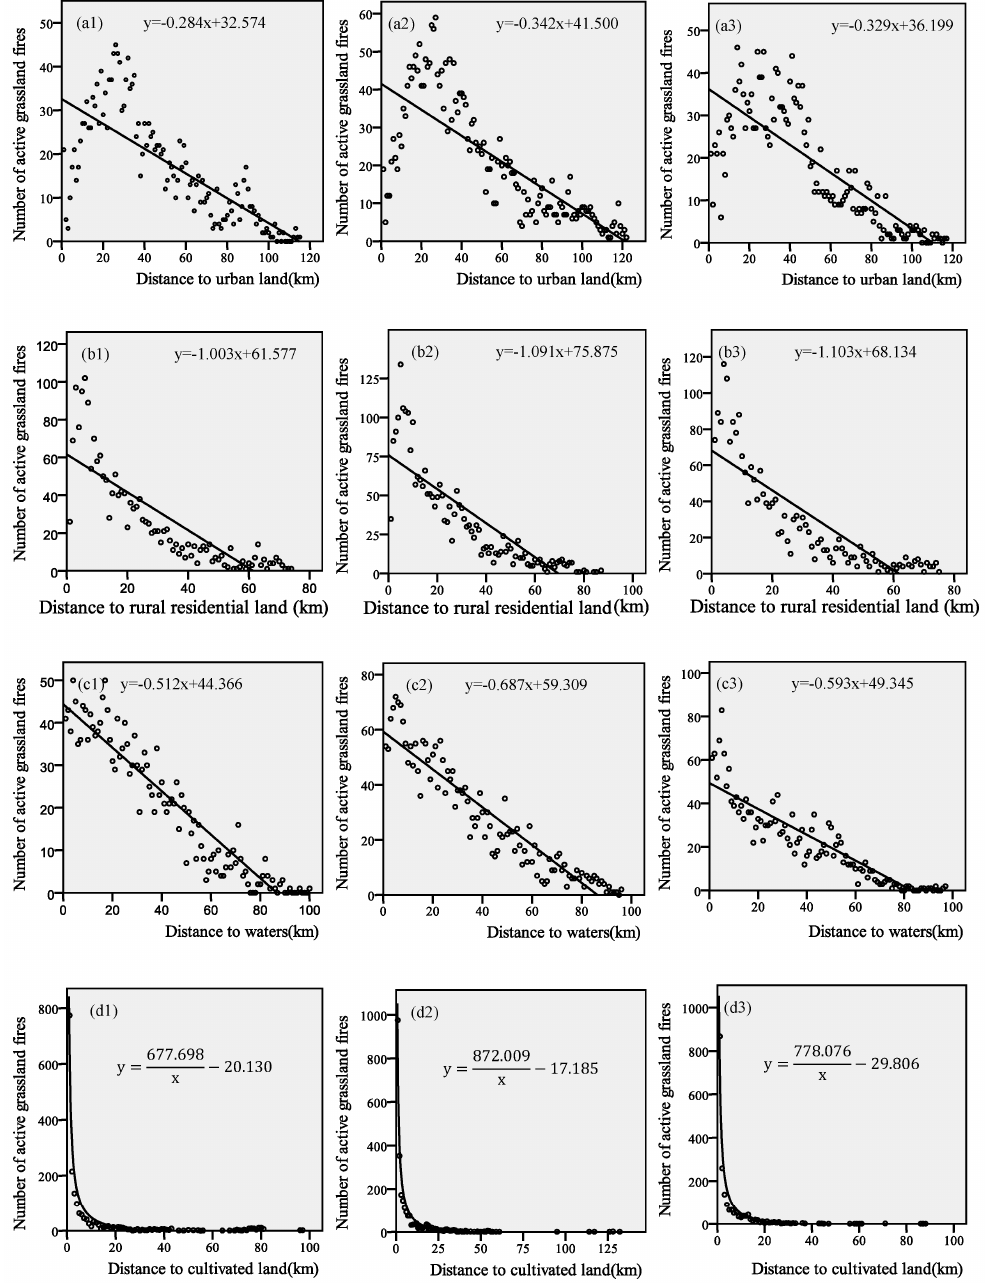
Figure 6. Effects of various land uses on the spatial distribution of grassland fires: ( a1 – a3 ) urban land (2000–2010); ( b1 – b3 ) rural residential land (2000–2010); ( c1 – c3 ) cultivated land (2000–2010); ( d1 – d3 ) water (2000–2010).